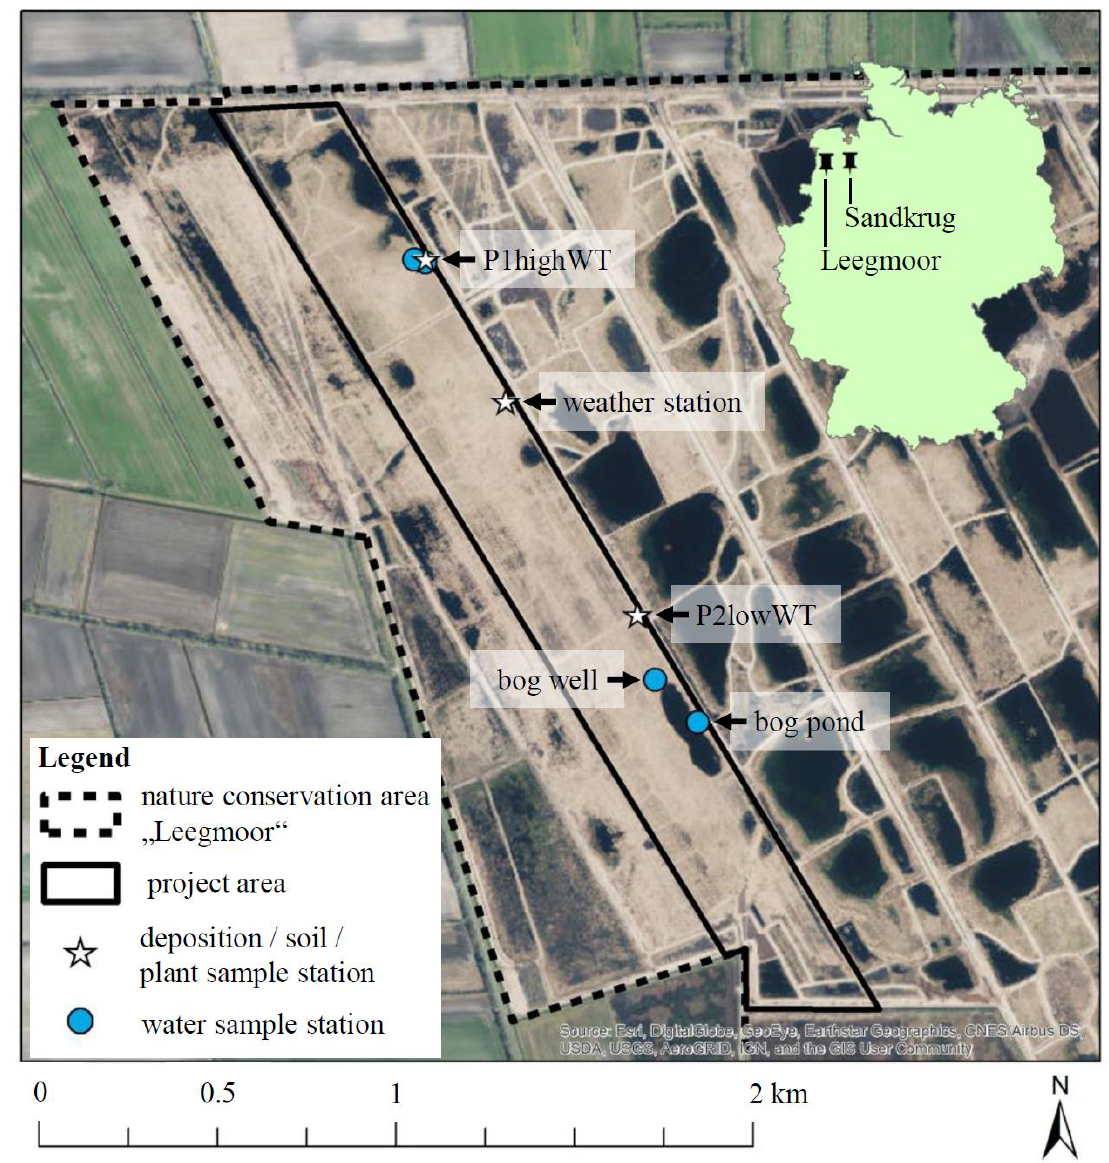
Figure 1. Map of the “Leegmoor” project area in Northwest Germany. P1highWT: sampling station in the north with higher water table; P2lowWT: sampling station in the south with lower water table; bog and surface water sampling stations at P1highWT are located directly at the passive sampling station; water sampling stations at P2lowWT are indicated as bog well (bog water sampling) and bog pond (surface water